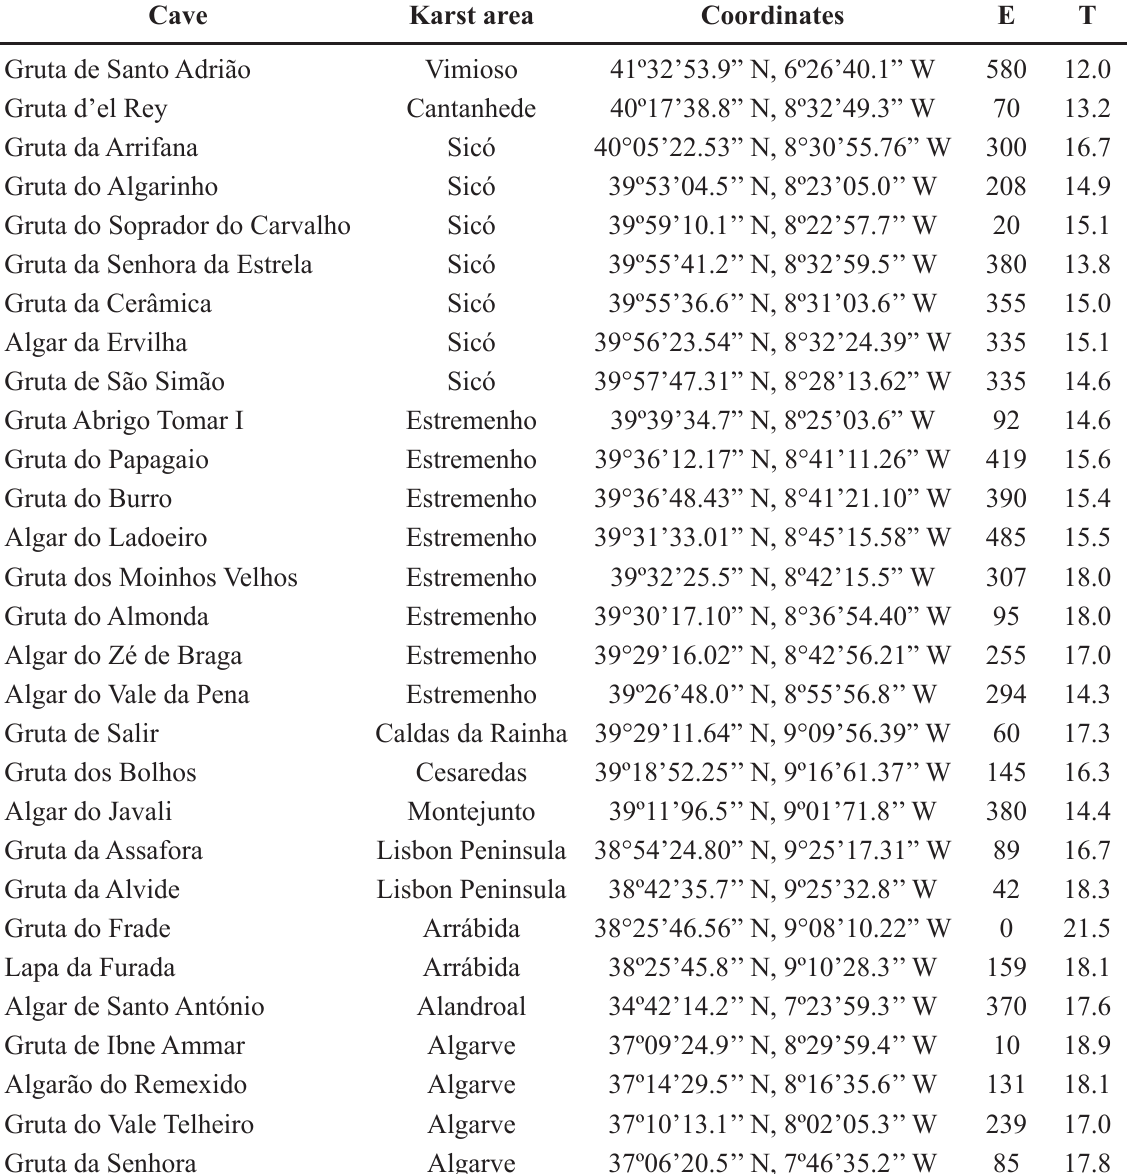
Table 1. Studied caves in Portugal. Coordinates: UTM WGS; E = entrance altitude in metres; T = mean temperature at soil level in